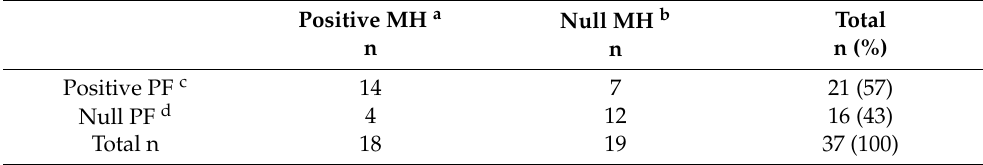
Table 3. Summary of results of included trials from the Dray et al. systematic review that included a measure of protective factors (PFs) [27]. Positive MH a Null MH n